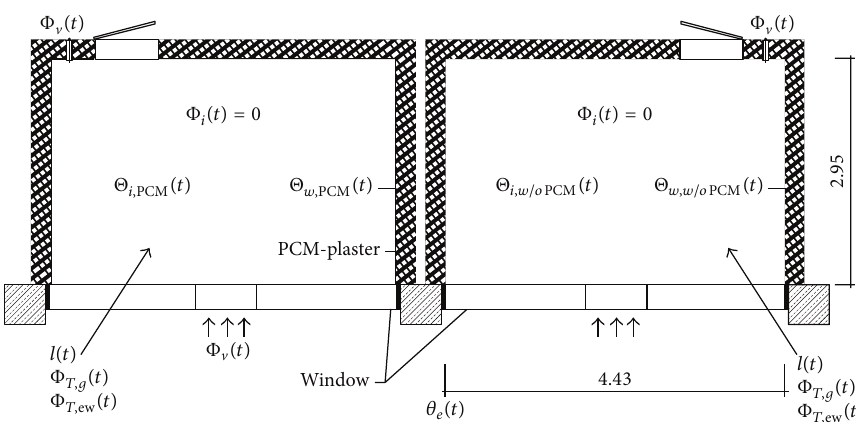
Figure 11: Test rooms (on the left with PCM plaster).